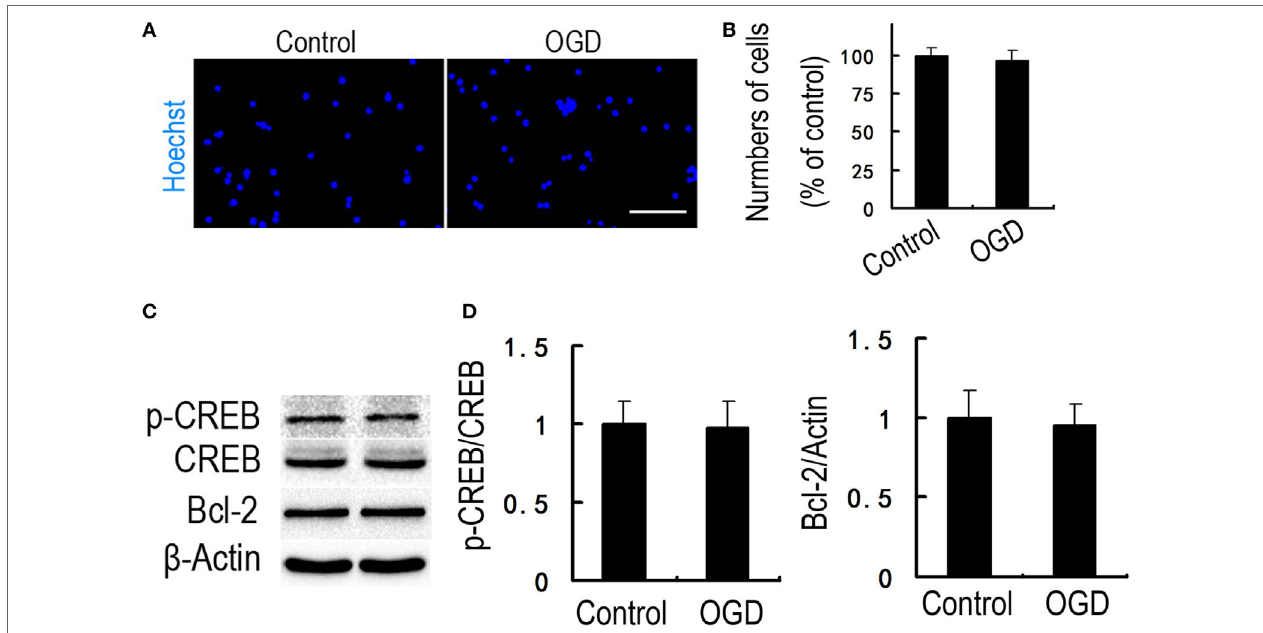
FigUre 5 | There are not differences in neuronal viability immediately after oxygen glucose deprivation (OGD). (a) Immunofluorescence of viable neurons. Nuclei were stained with Hoechst 33258 (blue). (B) Statistical graph from data in (a) , n = 5. (c) Immunoblots image showing phospho-CREB (p-CREB) and B-cell lymphoma-2 (Bcl-2) in primary hippocampal neurons cultured in the plain medium (control) or exposed to OGD. (D) Statistical graph from data in (c) , n = 5. Data are mean ± SEM. Scale bars = 50 µm (a)